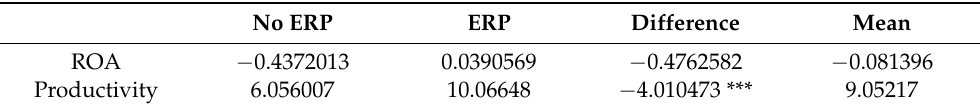
Table 2. Differences between companies that implemented and those that did not implement ERP systems.